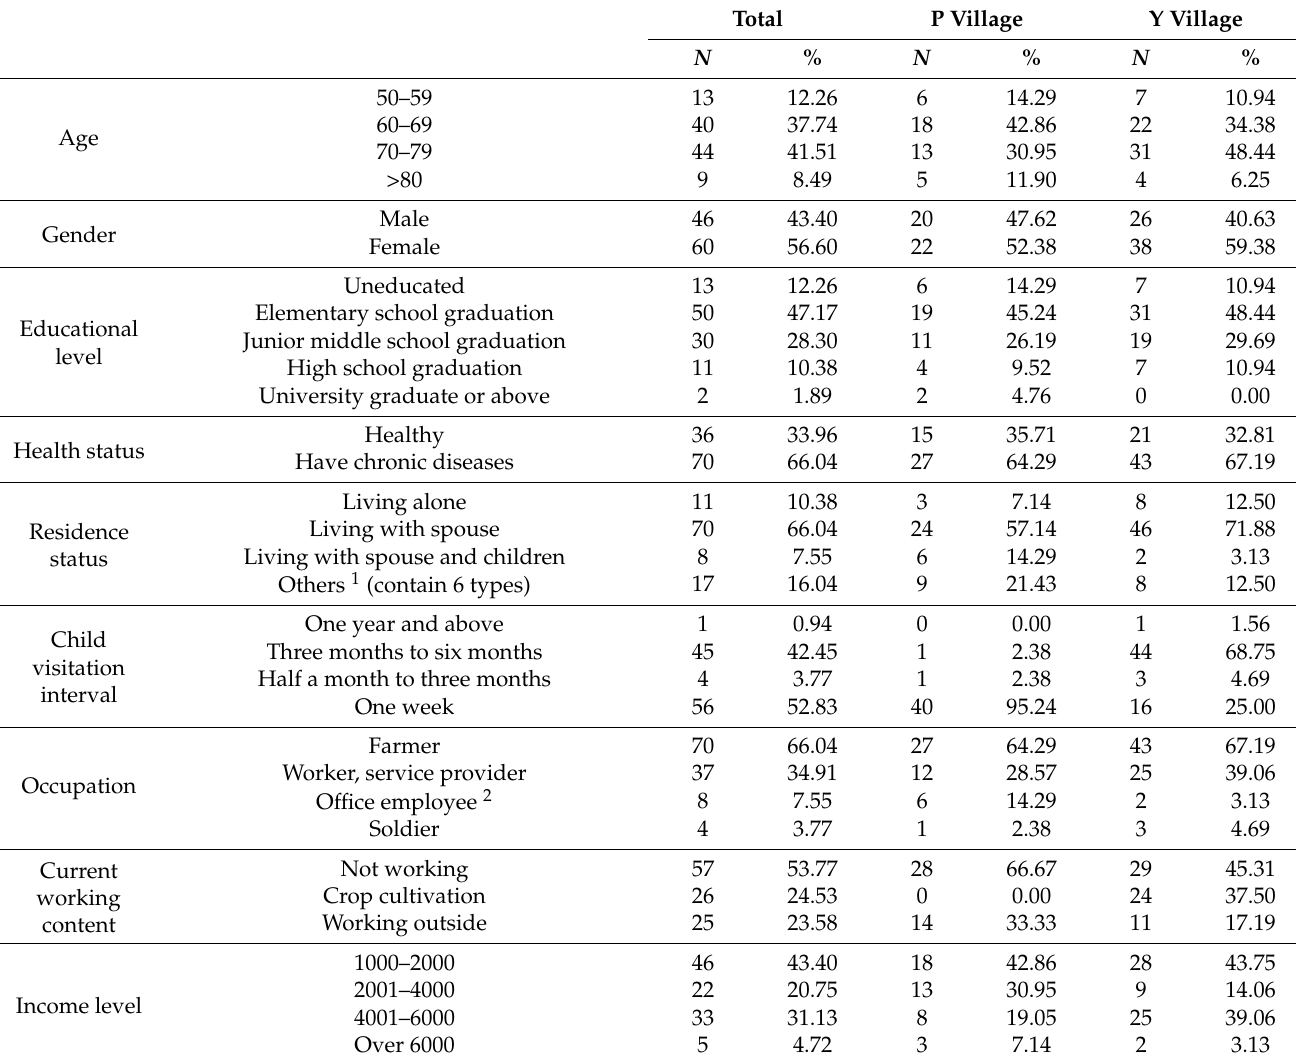
Table 2. Basic information statistics of the respondents.